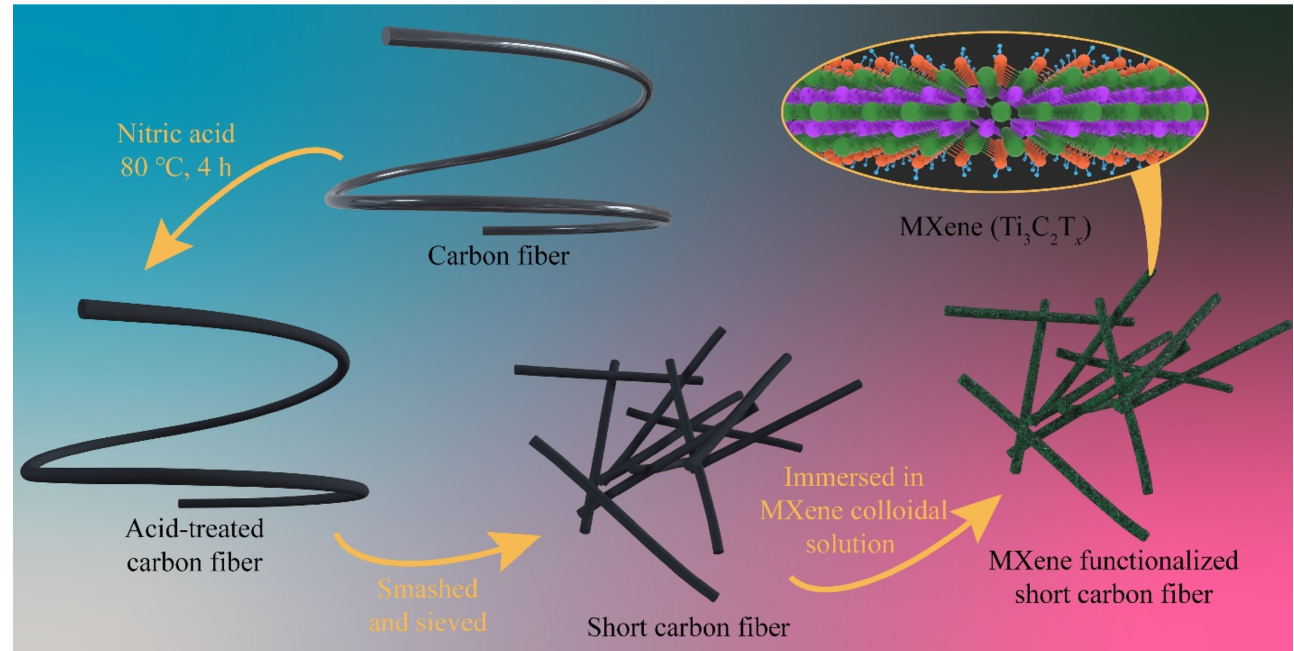
Figure 1. Schematic representation of MXene functionalized